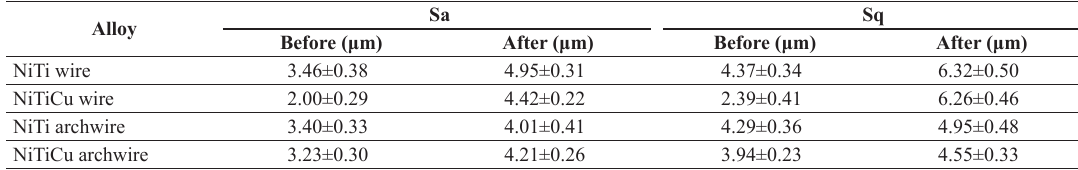
Table 3. Roughness parameters obtained from confocal